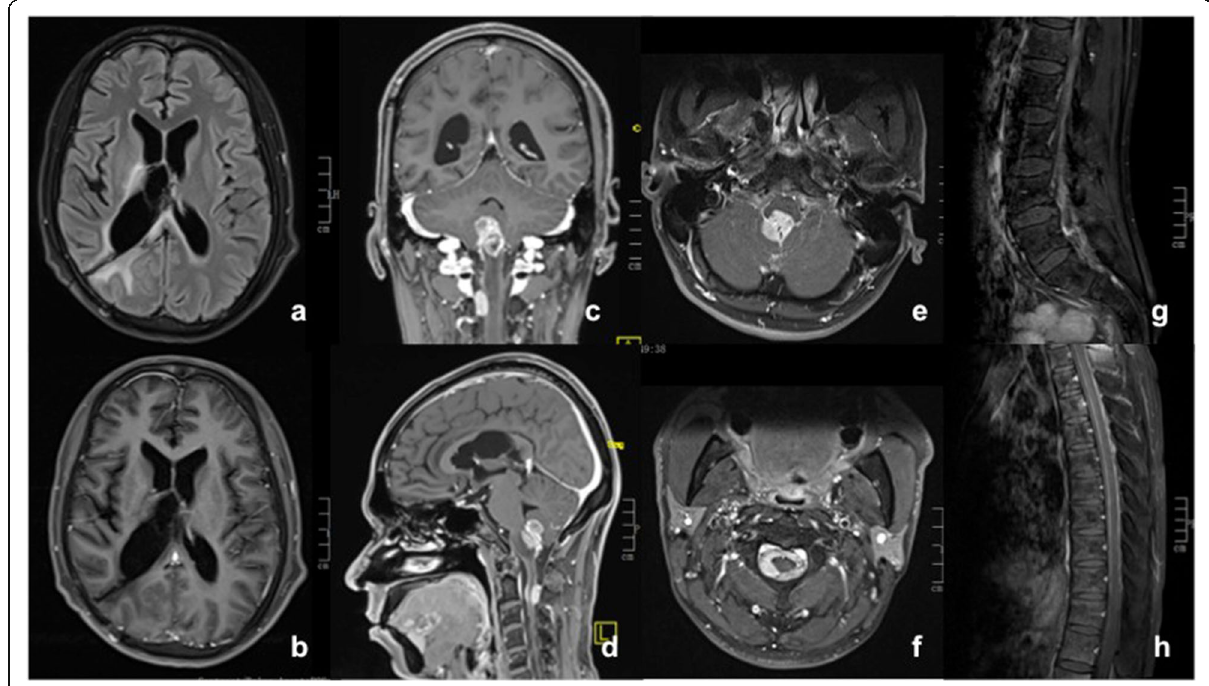
Fig. 6 Axial a T2 FLAIR and b T1 contrast sections of brain showing near complete resolution of the primary lesion. c – f There is interval development of heterogeneously enhancing mass lesion (2.4 × 2.0 × 1.4 cm) in the inferior part of fourth ventricle causing marked compression on dorsal medulla. Another heterogeneously enhancing nodular lesion (1.1 × 0.6 × 1.4 cm) seen in right posterior subarachnoid space at the level of C2 vertebra causing mild compression of the posterior cervical spinal cord. Abnormal leptomeningeal enhancement is seen along the surface of brainstem and cerebellum. g , h Abnormal leptomeningeal enhancement is also seen along the surface of entire spinal cord with